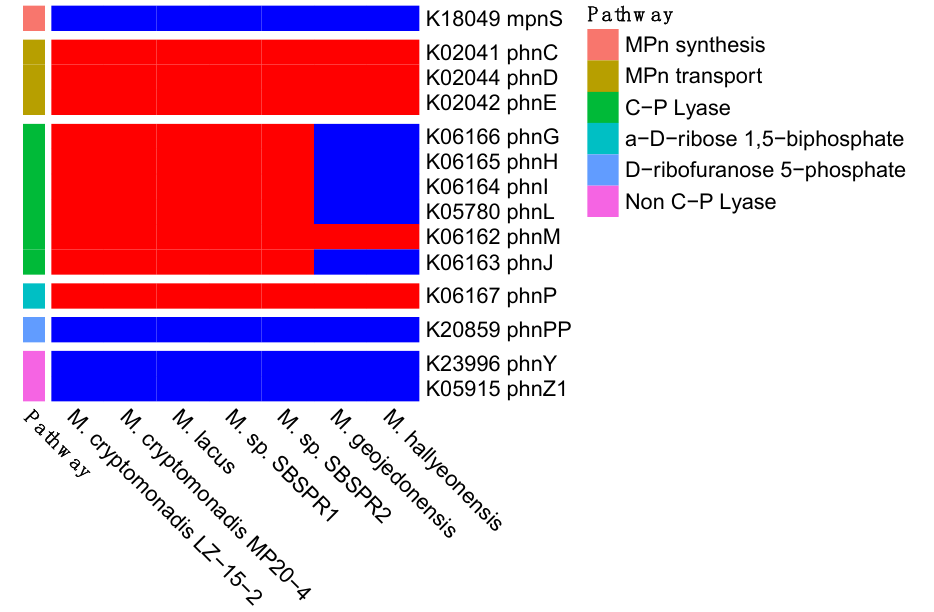
Figure 3. Presence ( red ) or absence ( blue ) methylphosphonate synthesis, transport, and degradation genes, with their abbreviated names and KEGG K number assignments. Shown here are the core C-P lyase pathway genes followed by two different post-methane pathways ( phnP or phnPP ), as well as the non-C-P lyase pathway.